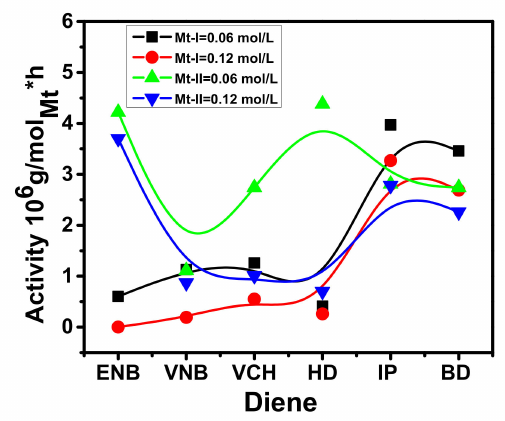
Figure 2. Activity of ethylene/diene (conjugated and nonconjugated) copolymerization with complex A and complex B at 0.06 mol/L and 0.12 mol/L.